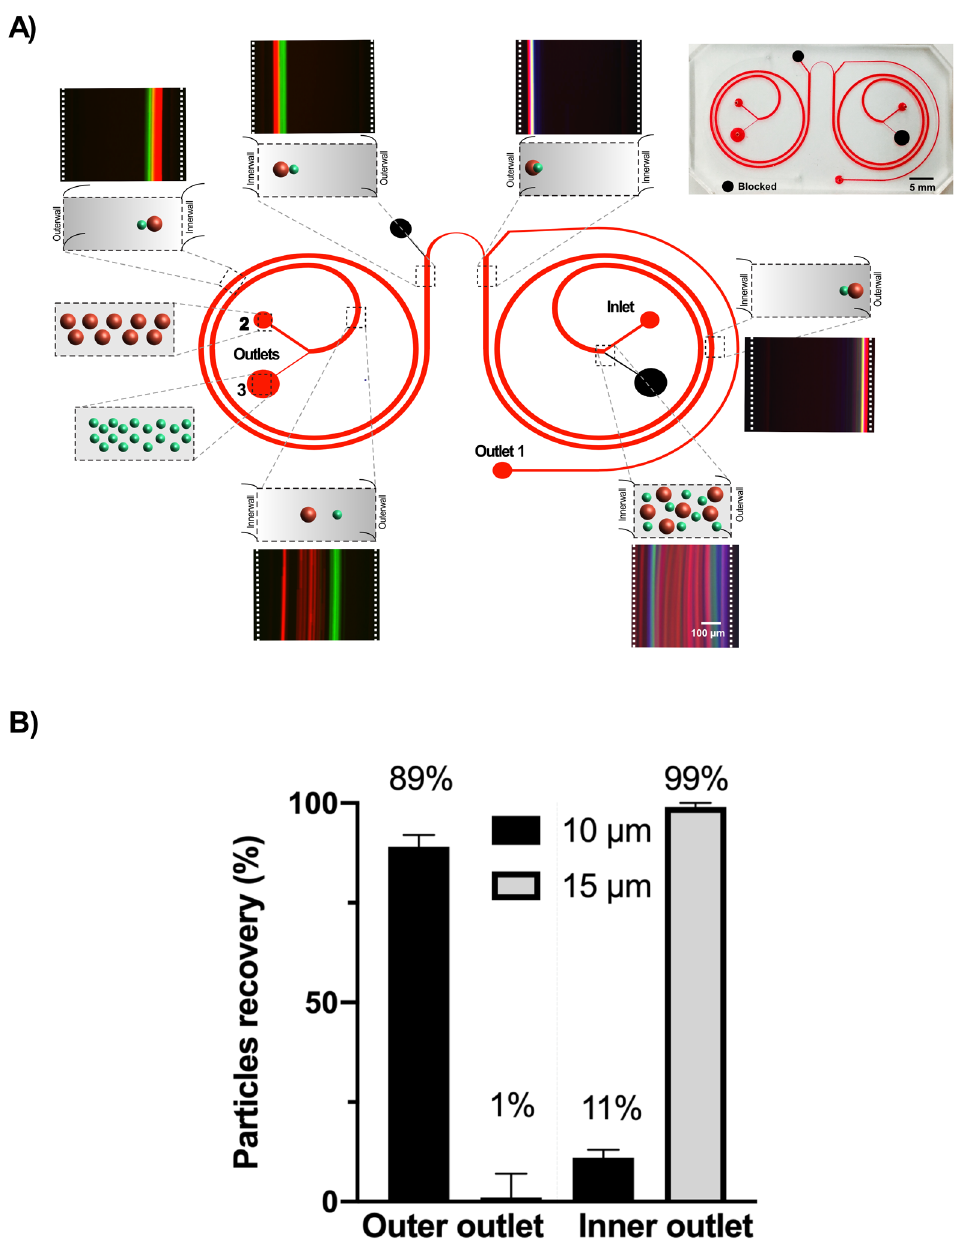
Figure 8. Sheath-less flow for high throughput particle separation using integrated spiral. Experimental results of two integrated spiral. ( A ) Particle size with 10 and 15 μm introduced at the inlet, where 10 and 15 μm particles are pre-focused in the first spiral and follows to the next spiral, where the 15 μm particles remains at the inner wall, while the 10 μm particles moves towards the outer wall of the channel. ( B ) Separation of particle 10 and 15 μm at a high flow rate of 1 ml/min, indicating a separation efficiency of 89% for 10 µm particles at the outer outlet and 99% for 15 µm particles at the inner